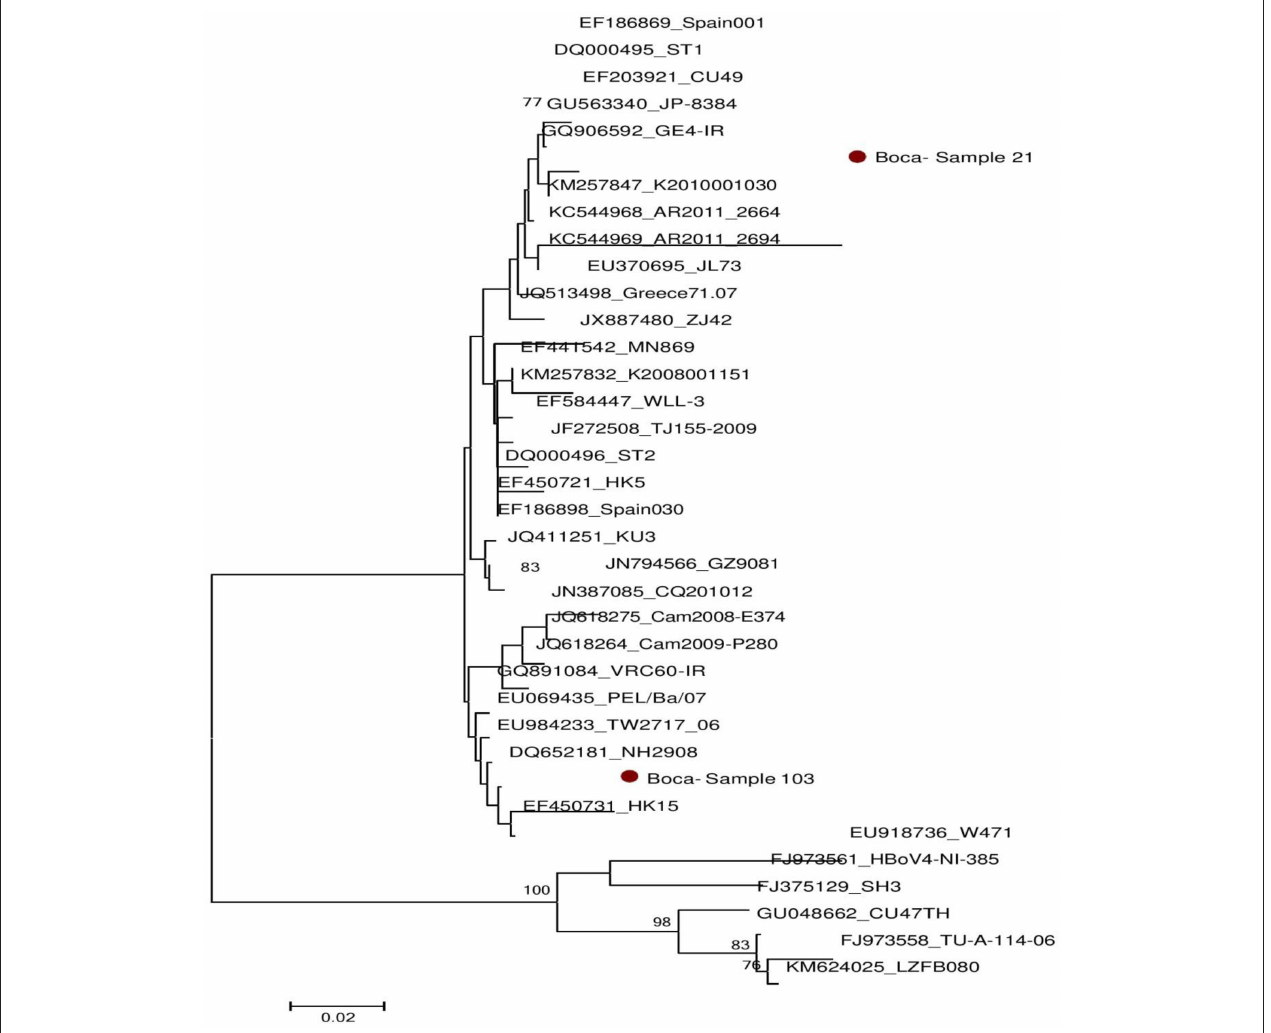
FIGURE 3 | Phylogenetic analysis of Bocavirus sequences isolated in Sudan (21,103). The VP1 region was used for genotyping (see supplementary Data Sheet 3). The Kimura’s two-parameter model with 1000 replications of bootstrap sampling implemented in MEGA 5 was used to analyze the data. Only Bootstrap values > 70% are indicated at nodes. Bars show distances. •represent Sudan Boca virus isolates in this